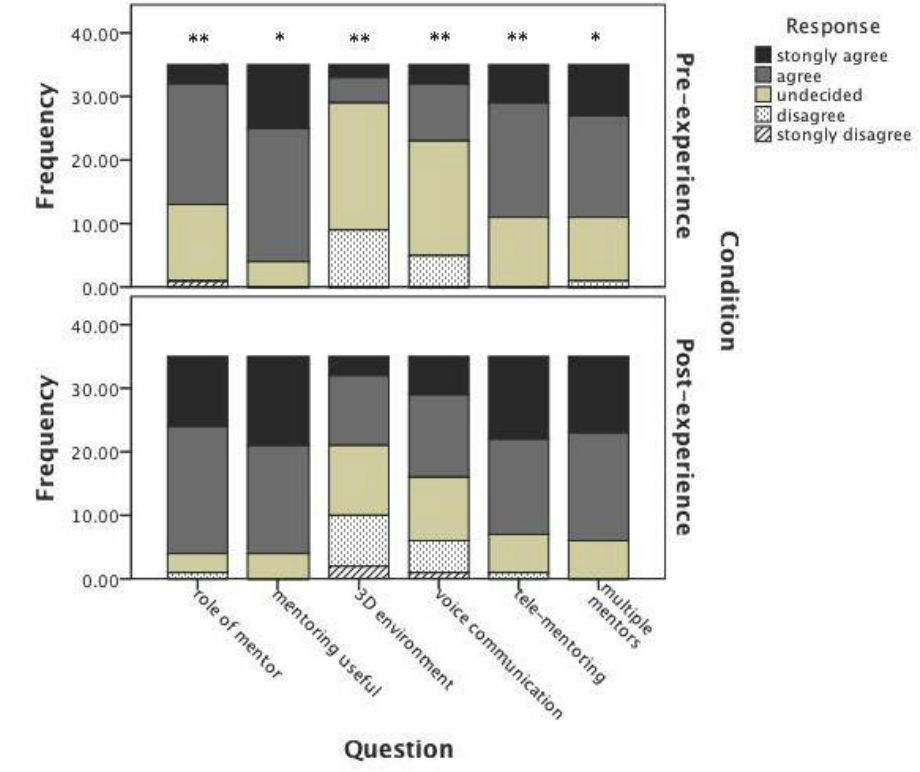
Figure 2. Stacked bar chart of response to questions pre- (above) and post-experience (below) of the MentorSL system. *Improvement in response; P <.05, **improvement of response; P <.001 (one-way chi-square